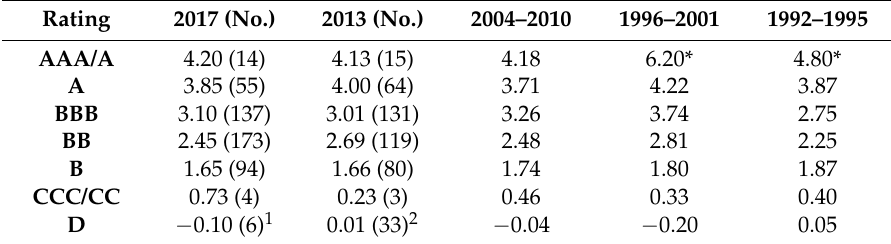
Table 2. Median Z-Score by S&P Bond Rating for U.S. manufacturing firms: